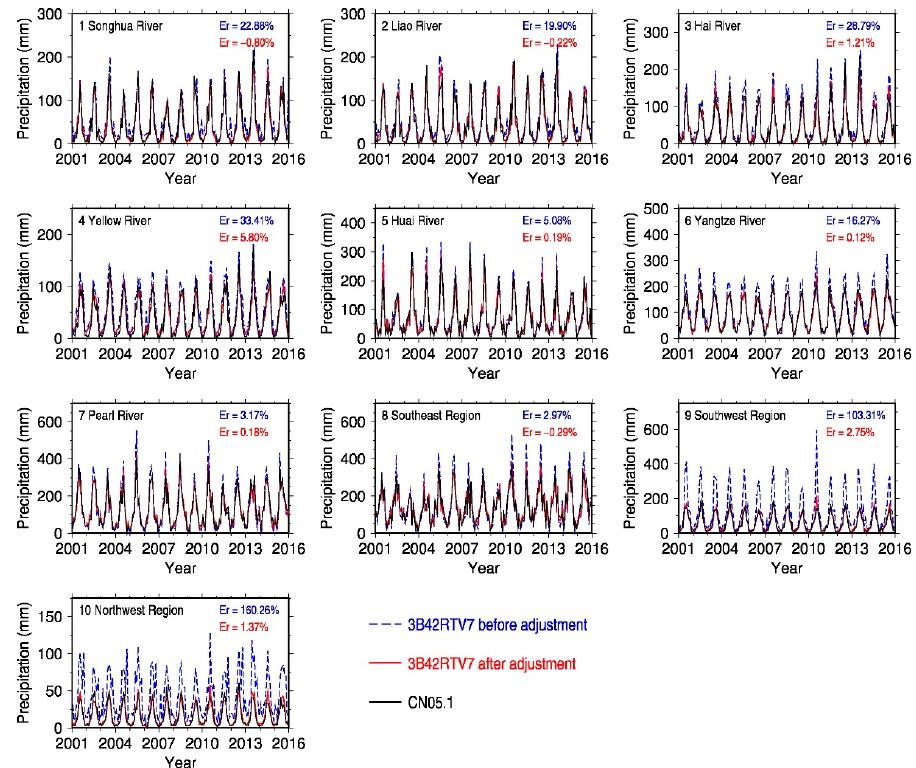
Figure 3 . Comparisons of monthly precipitation from the 3B42RTV7 before adjustment (blue dash line), 3B42RTV7 after adjustment (rea line), and the gauge-based CN05.1 data (black line) during the overlapping period (2001–2016) for the 10 hydrological zones as shown in Figure 1.